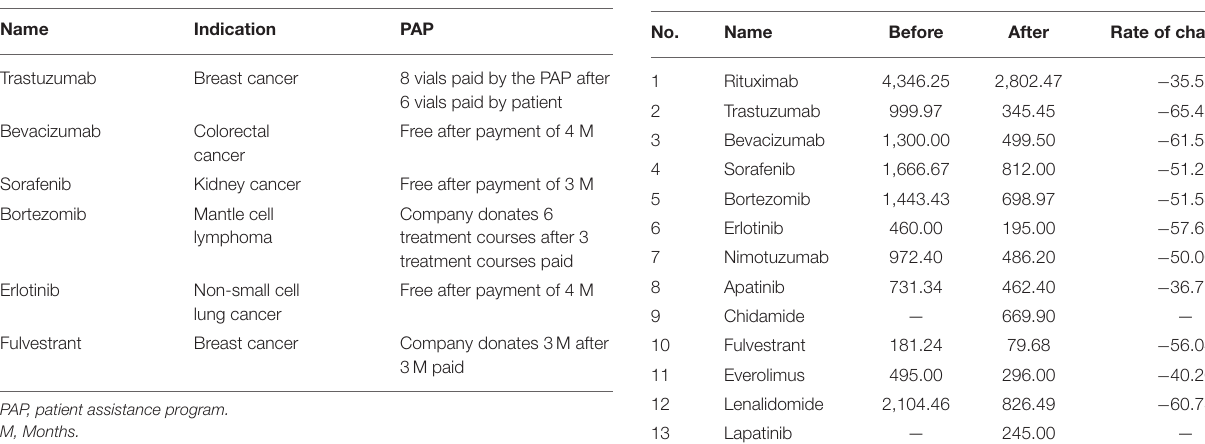
TABLE 3 | Prices of 15 innovative anti-cancer medicines before and after policy implementation